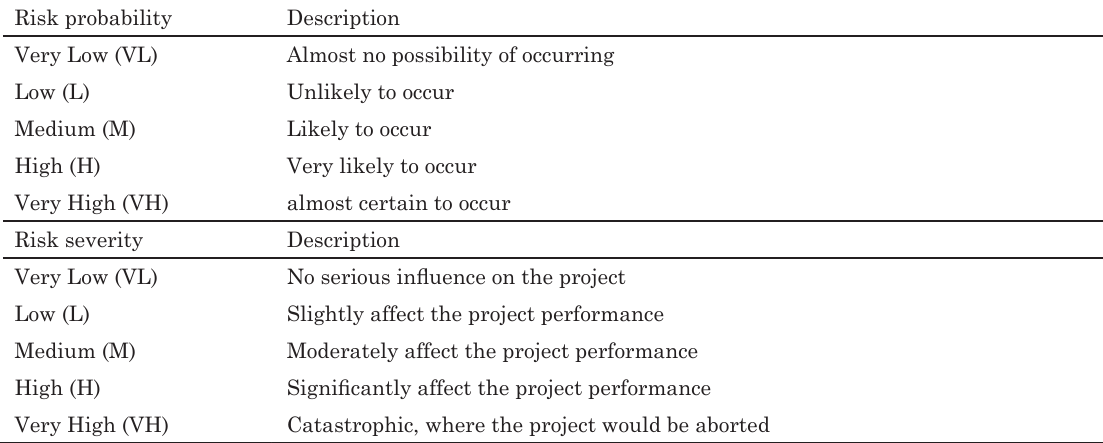
table 3. terms for describing risk probability and risk